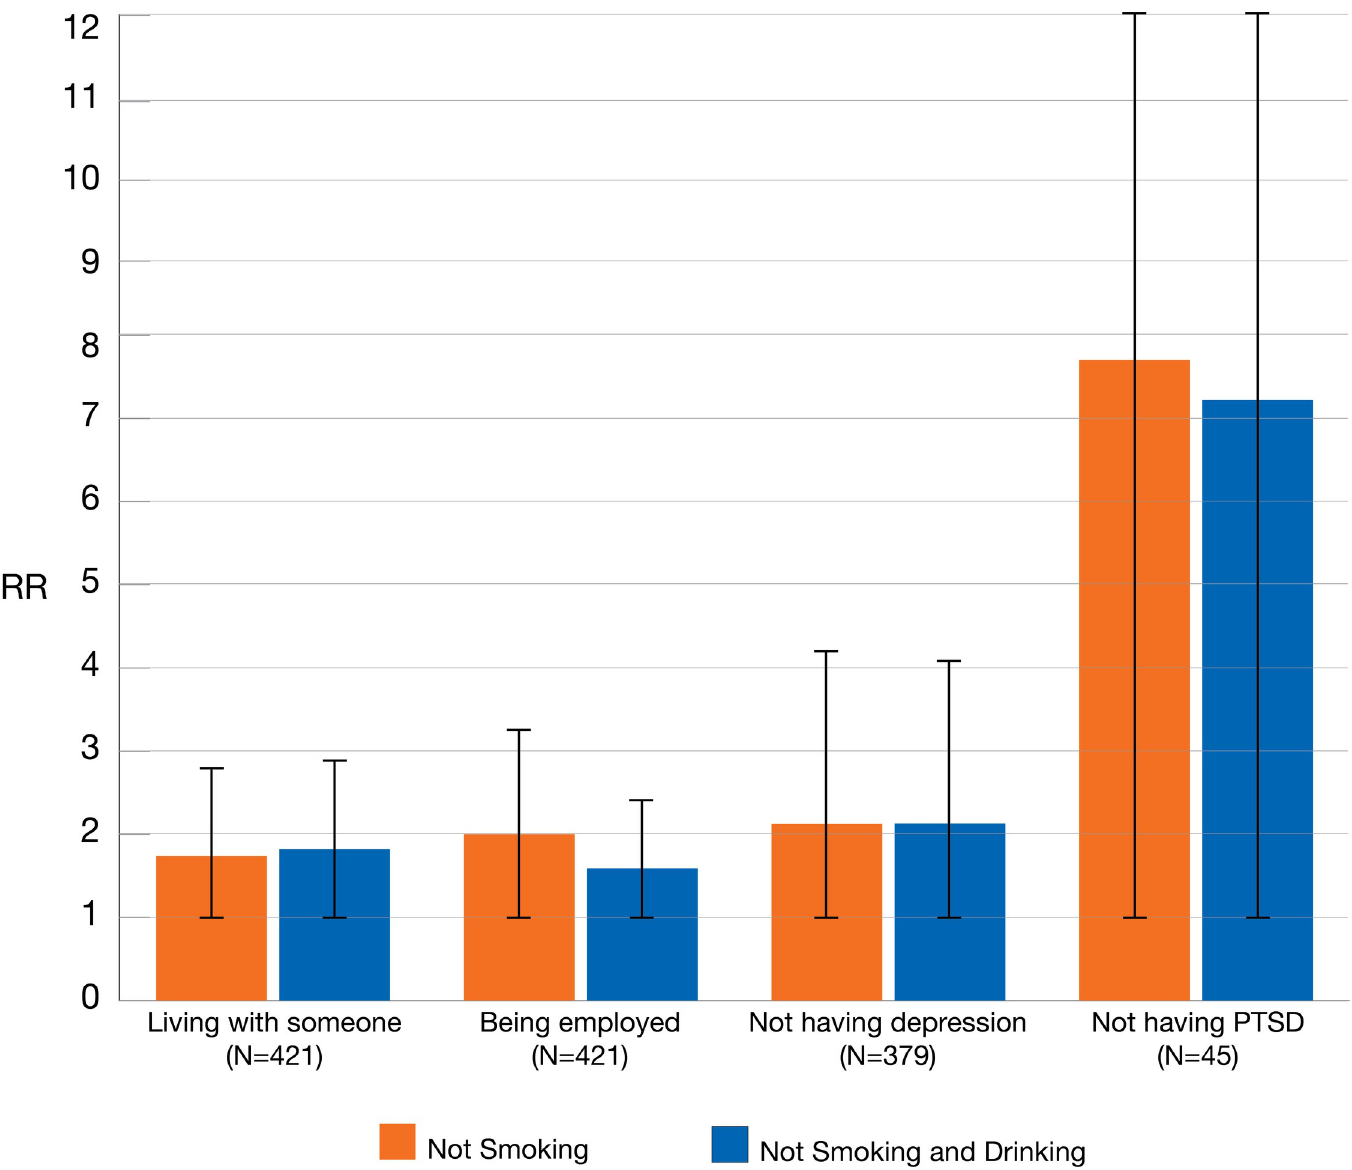
Fig 2. Likelihood of not smoking or not both smoking and drinking during pregnancy. This figure shows the relative risk of 1) not smoking during pregnancy and 2) not both smoking and drinking during pregnancy. These risks are based on maternal factors: living with someone, being employed, not having depression, and not having PTSD. They are all statistically significant. Each factor is protective against smoking during pregnancy and both smoking and drinking during pregnancy. Being employed is a stronger factor against only smoking than both smoking and drinking. Not having PTSD is the strongest protective factor, but also has the largest error due to small sample size. The upper limits of the CI’s for PTSD are not shown- they are 53.5 and